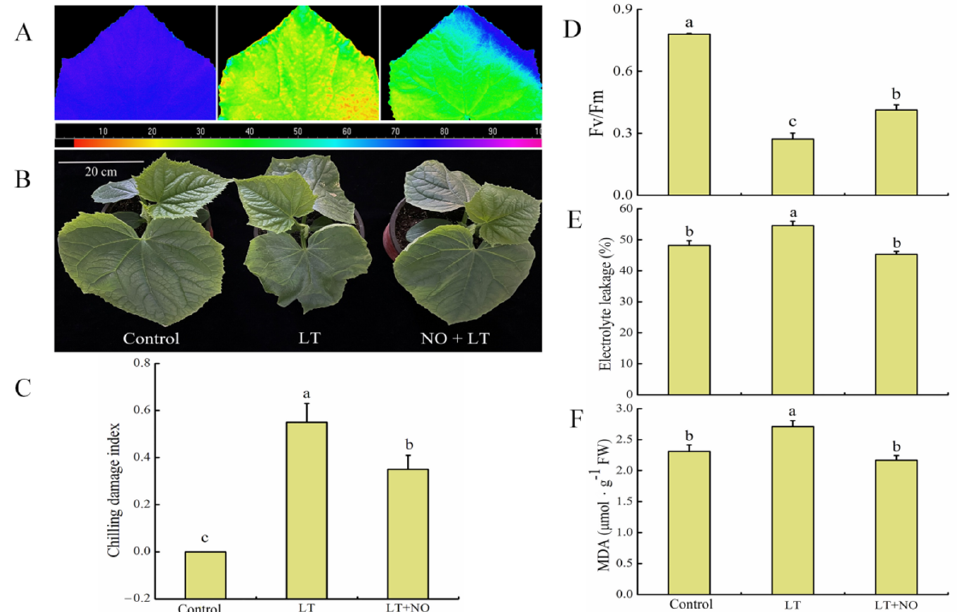
Figure 1. Effects of low temperature (LT) on photosynthetic apparatus and membrane stability in cucumber leaves as influenced by nitric oxide (NO) pretreatment. ( A ) Fv/Fm image, ( B ) plant phenotype, ( C ) chilling damage index, ( D ) Fv/Fm values, ( E ) electrolyte leakage, and ( F ) MDA content in cucumber leaves. Control, the cucumber seedlings were sprayed with distilled water and incubated under normal conditions; LT, the cucumber seedlings were sprayed with distilled water and incubated at 10 ± 1 ◦ C/6 ± 1 ◦ C (day/night) temperatures; NO + LT, the cucumber seedlings were sprayed with 200 µ mol · L − 1 SNP and incubated under LT condition. Data are an average of 6 replicates ± SE. Means denoted by different letters indicate a statistically significant difference at p <